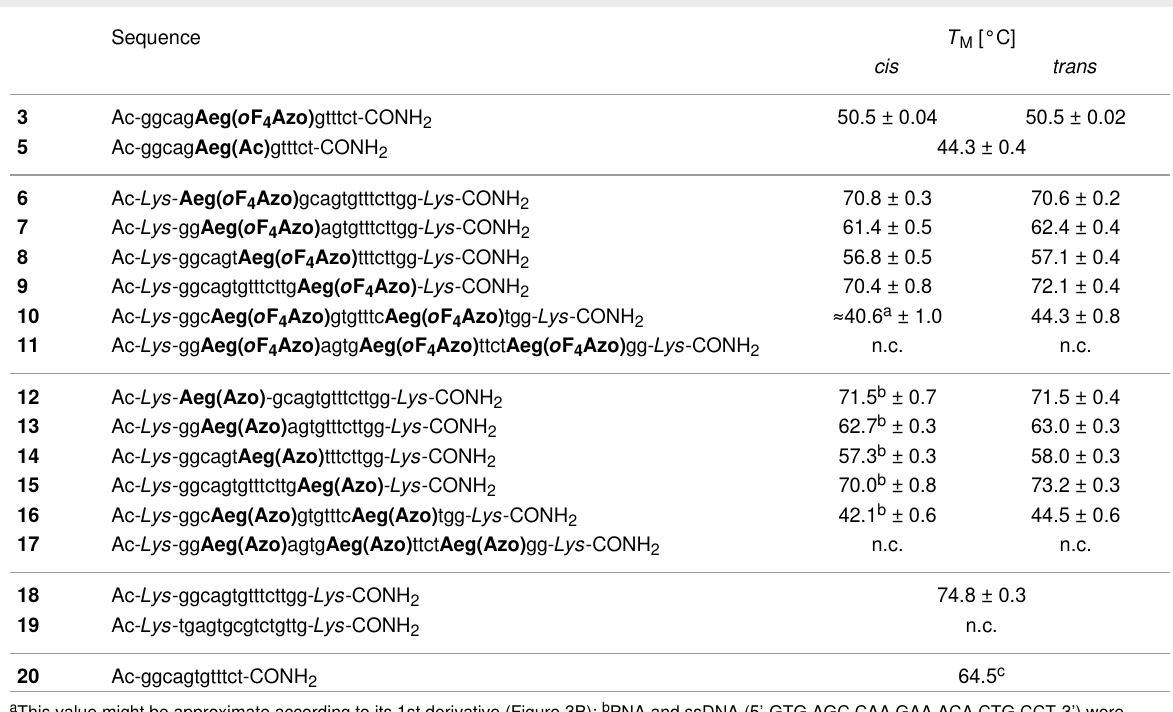
Table 2: Melting temperatures ( T M ) of the duplex between the PNAs and the complementary ssDNA (5’-GTG AGC CAA GAA ACA CTG CCT-3’).